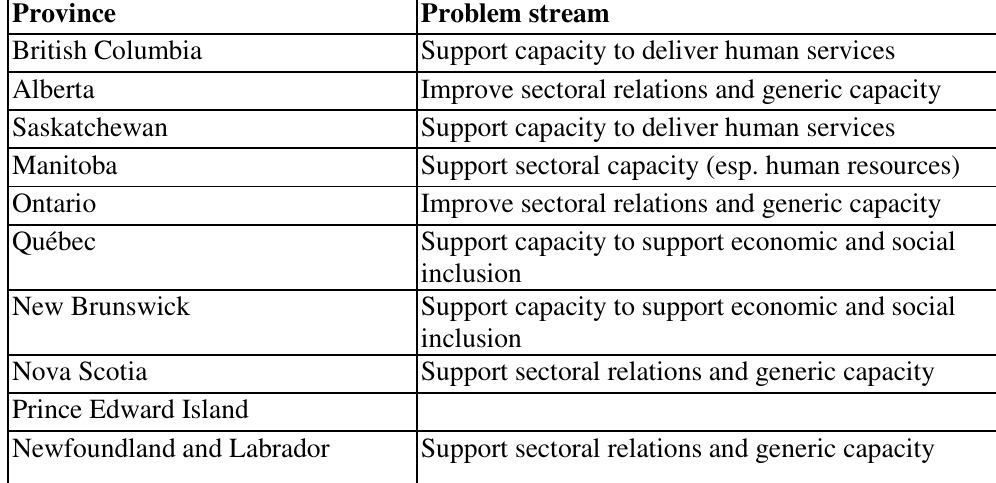
Table 2: Provincial Problem